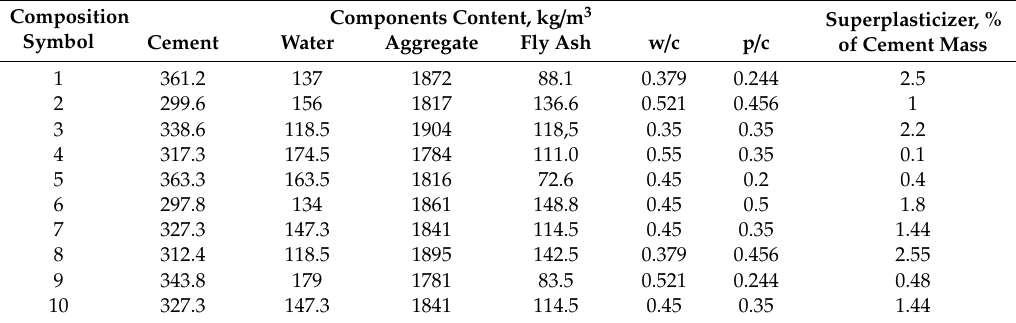
Table 6. Concrete mix compositions (constant value of cement and fly ash to aggregate mass coe ffi cient = 0.24; constant consistence 12 ± 2 cm of slump), w / c—water / cement mass ratio, p / c—fly ash / cement mass